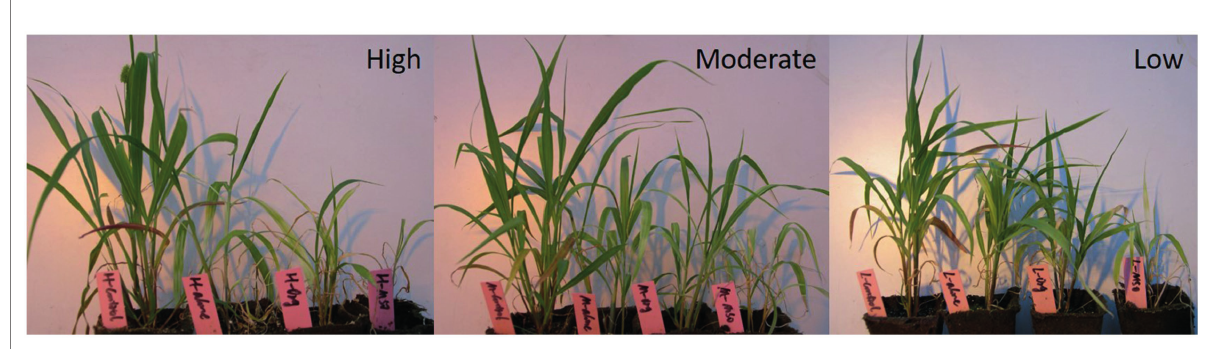
FIGURE 3 Images of giant foxtail taken at 3 weeks after herbicide application. The topramezone dose was 6.3 g a.i. ha − 1 ; control means treated with tap water; Alone means topramezone was applied alone; Org means topramezone was applied together with organosilicone; MSO means topramezone was applied together with